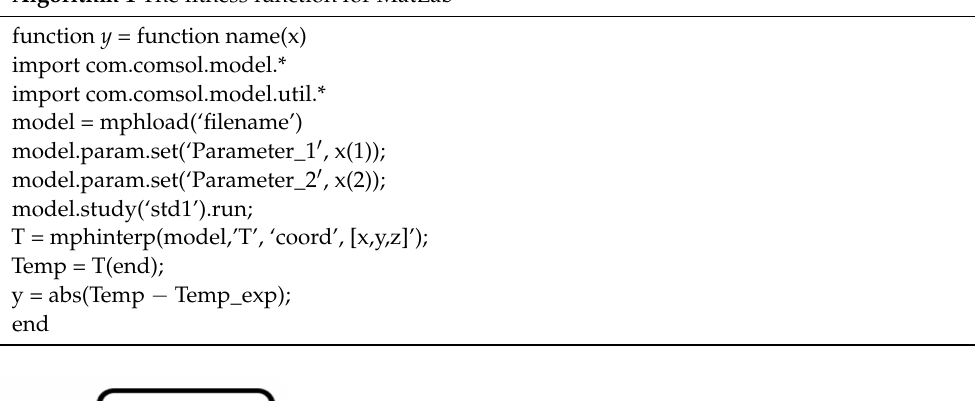
Algorithm 1 The fitness function for MatLab